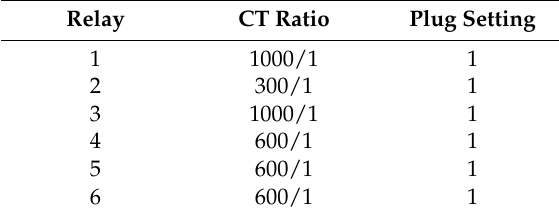
Figure 8. A single end-loop distribution system. Table 6. CT ratios and plug settings of the relays for Case 2.